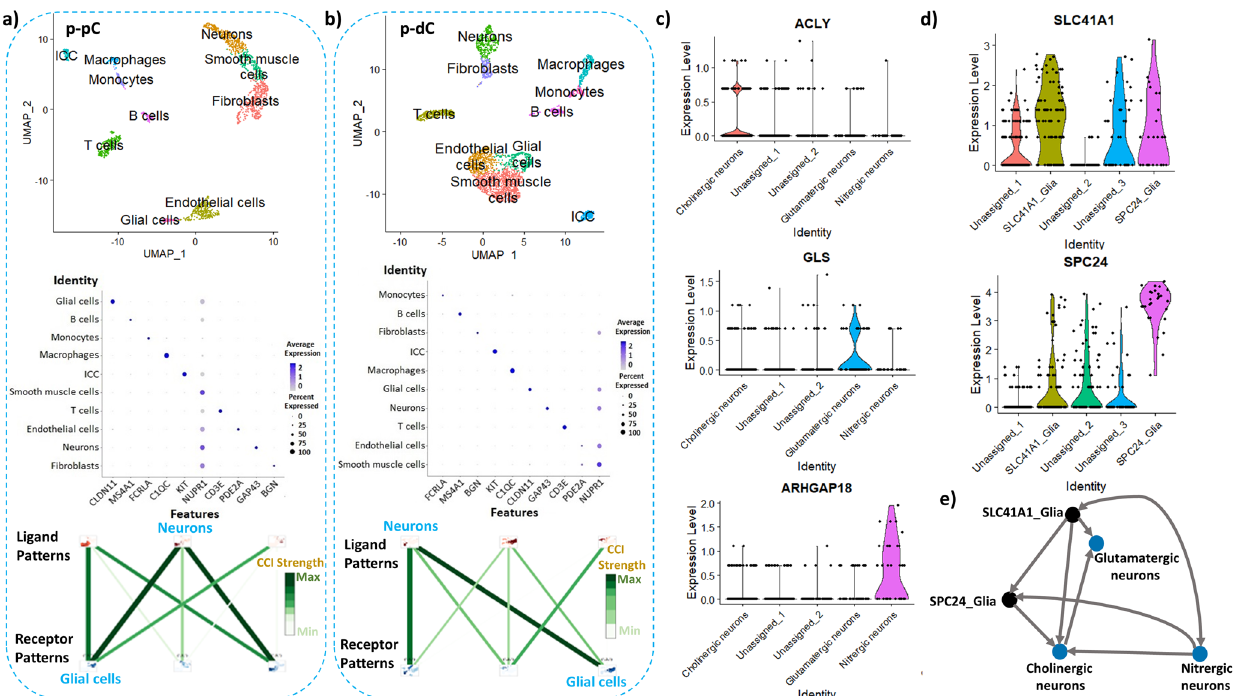
Fig. 4 Visualization of cell types and their interaction strength in the colonic muscularis externa of naive pigs by single-cell RNA sequencing. The clusters were labeled according to their markers and only neuronal and glial cell markers were veri fi ed by in situ hybridization in the pig proximal colon (p- pC) a and pig distal colon (p-dC) b . Uniform Manifold Approximation and Projection (UMAP) visualized 10 distinct cell clusters and the cell-cell interaction (CCI) strength between neurons and glial cells was highlighted only. Color represents a CCI strength distribution from maximum (green) to minimum (white). The distinct cell clusters were derived from 2091 cells of one p-pC individual and from 3918 cells of one p-dC individual. Joint visualization based on four individuals of p-pC and p-dC could be found in Supplementary Figure 3. Violin plots depict the distribution of gene expression levels for 3 neuronal subpopulations c and 2 glial subpopulations d . Interactions (arrows) from ligand- to receptor-expressing neuronal and glial subsets e . Blue, neuronal subset; Black, glial subset. Growth associated protein 43 (GAP43), a marker for annotating pan-neurons; Claudin 11 (CLDN11) for pan-glial cells; ATP citrate lyase (ACLY) for cholinergic neurons; Glutaminase (GLS) for glutamatergic neurons; Rho GTPase activating protein 18 (ARHGAP18) for nitrergic neurons; Solute